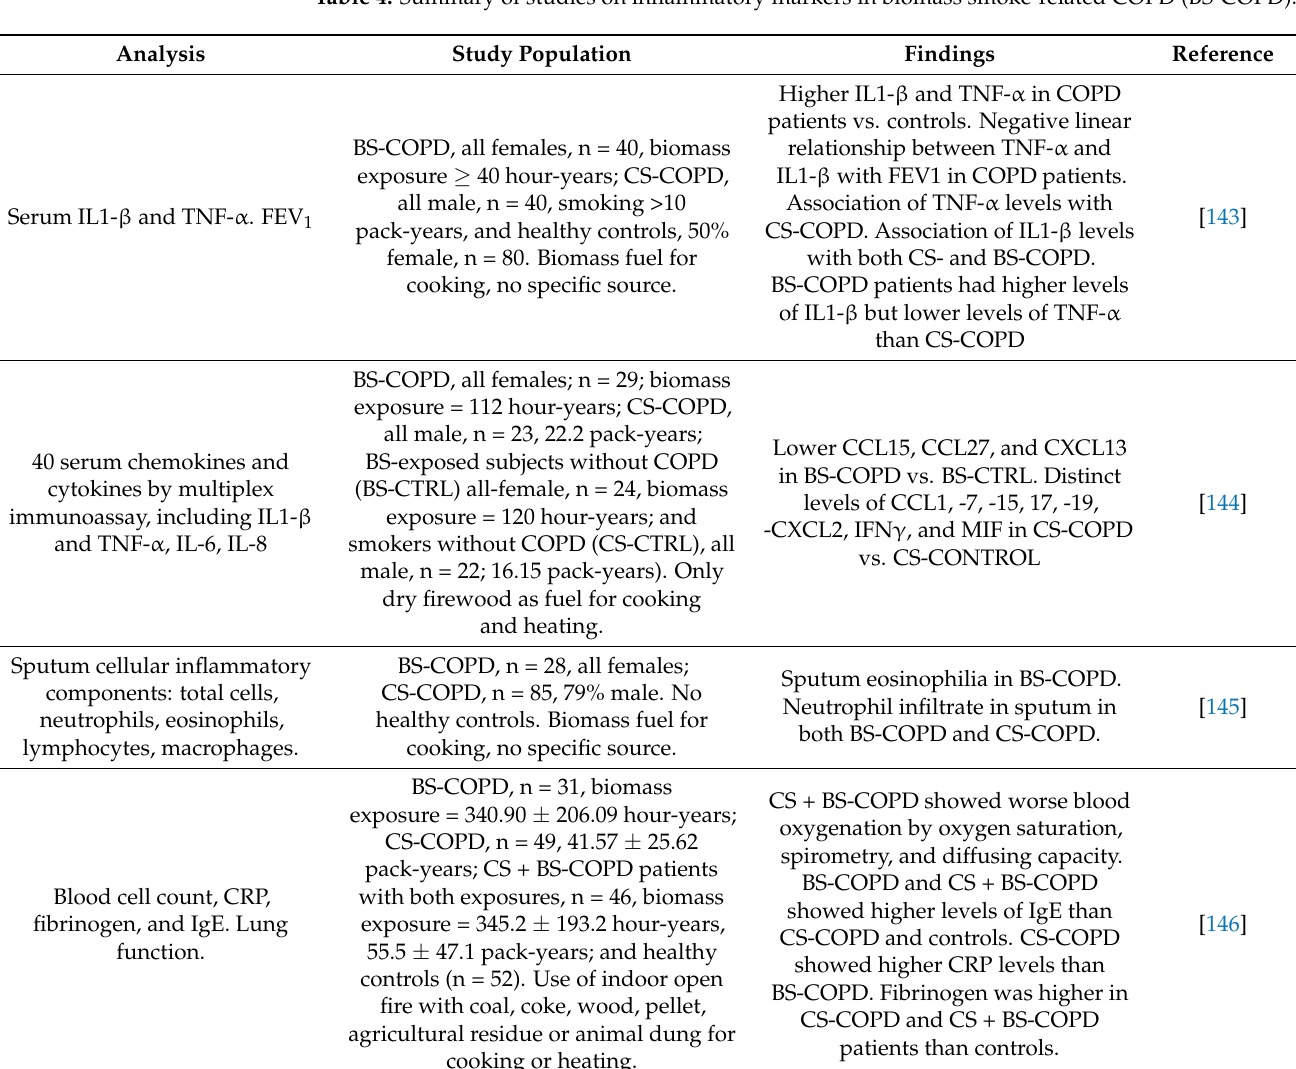
Table 4. Summary of studies on inflammatory markers in biomass smoke-related COPD